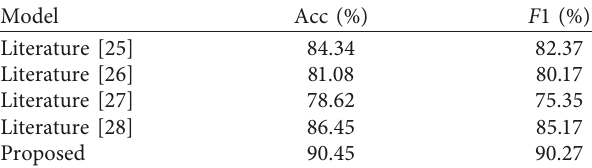
Table 5: Comparison of training time and model parameters.